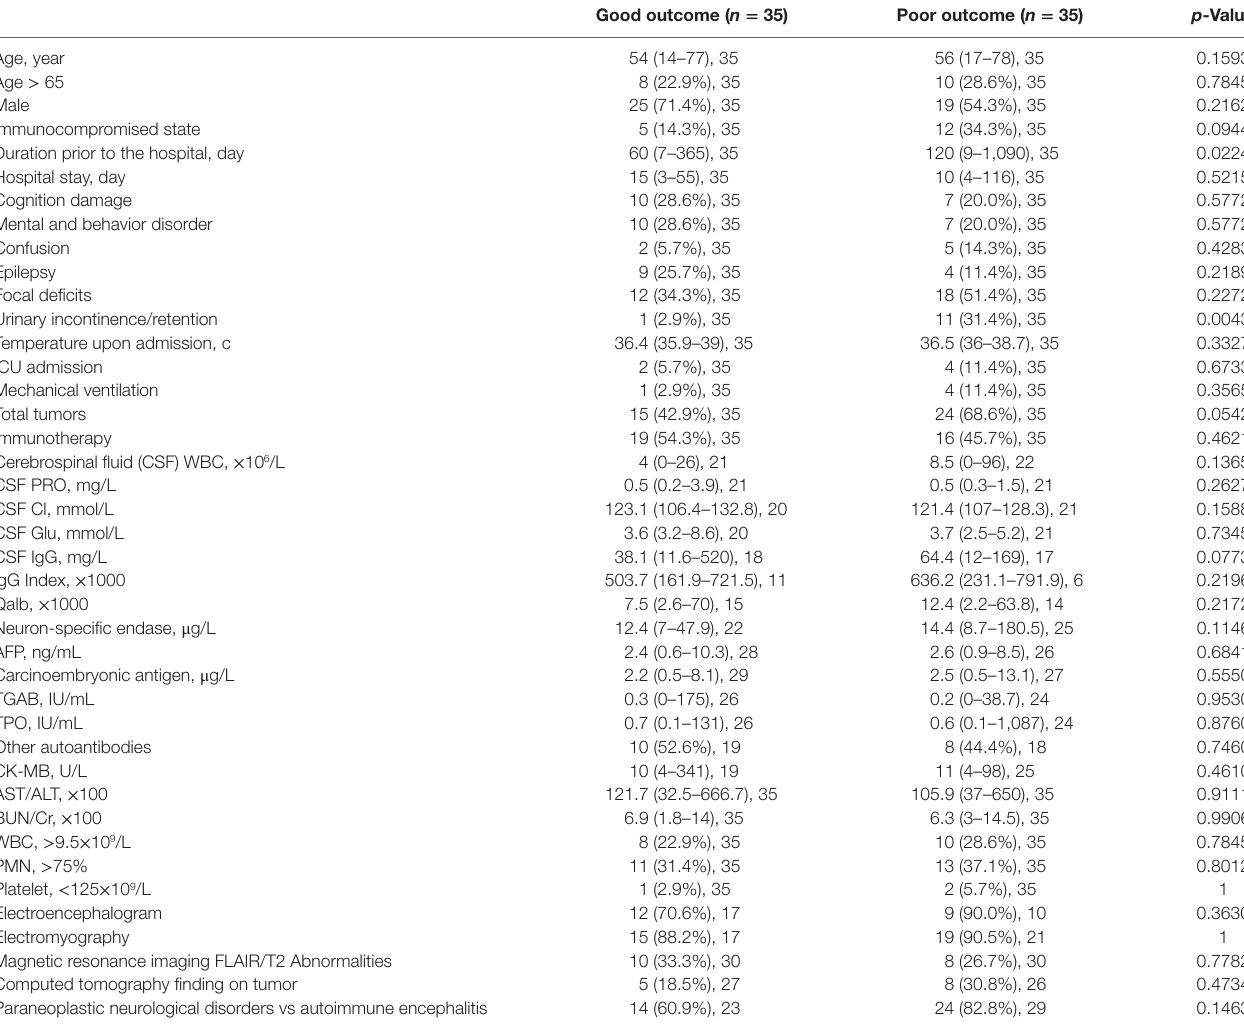
Data presented as positive specimen (%) sample size, or median (range) sample size.